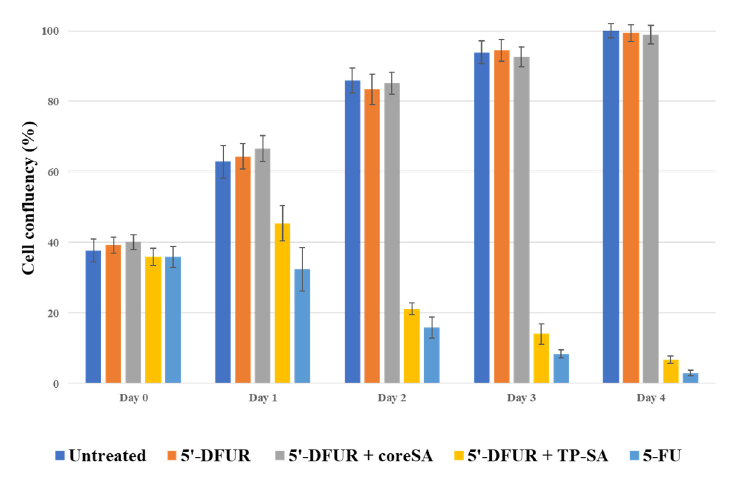
Figure 7. Viable cell confluency of A549 cells after treatment with nothing, 5 ′ -DFUR, 5 ′ -DFUR + coreSA, 5 ′ -DFUR + TP-coreSA, and 5-FU for 4 days of culture. Cell inoculation for all groups was about 38% confluency.